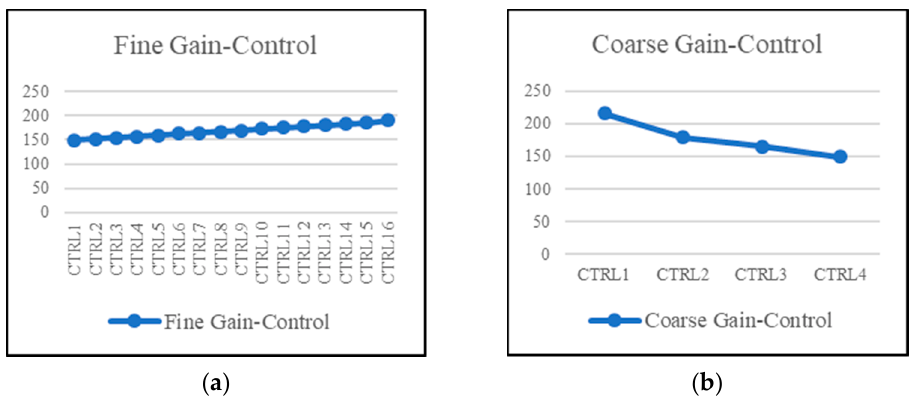
Figure 10. Gain of the TIA versus the ( a ) fine-gain controls and ( b ) the coarse-gain controls.